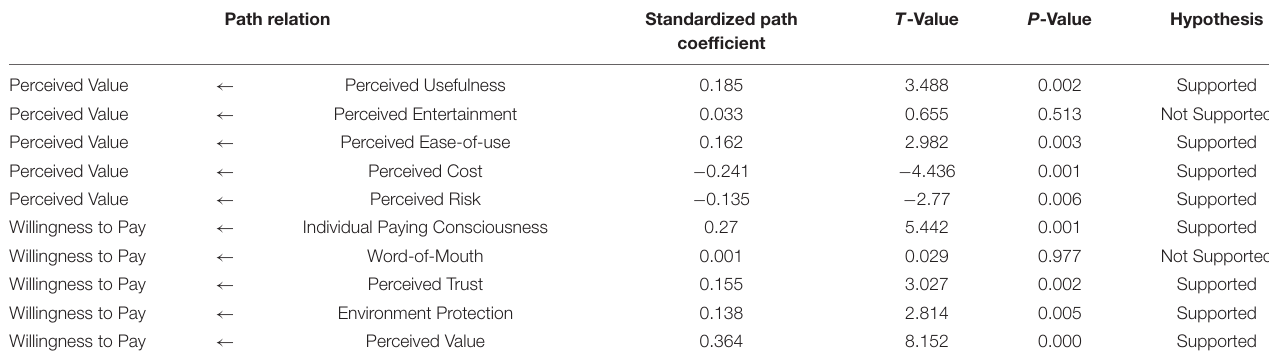
TABLE 5 | Path coefficient of structural equation